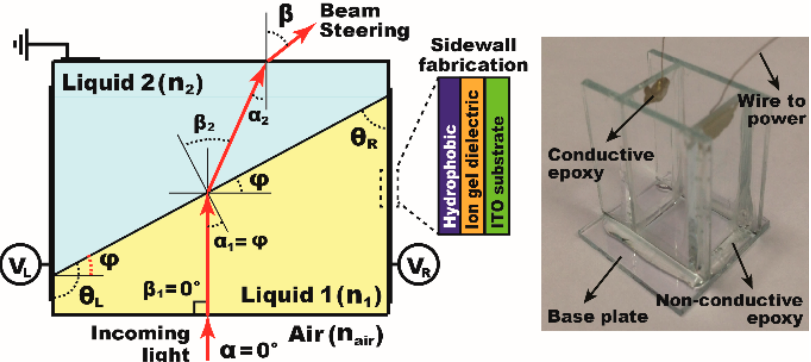
Figure 1. A rectangular prism is fabricated by assembling four conductive sidewalls coated with dielectric and hydrophobic layers and filled with two immiscible liquids. The electrowetting effect is used to adjust the prism apex angle ϕ by applying bias voltages (V L and V R ) to the left and right sidewalls, separately. Beam steering of the incoming light can be achieved at the interface of two media whose refractive indices are different ( n air ≠ n 1 ≠ n 2 ). The left figure shows the assembled prism device with a 10 × 10 mm 2 aperture area before two liquids are placed.